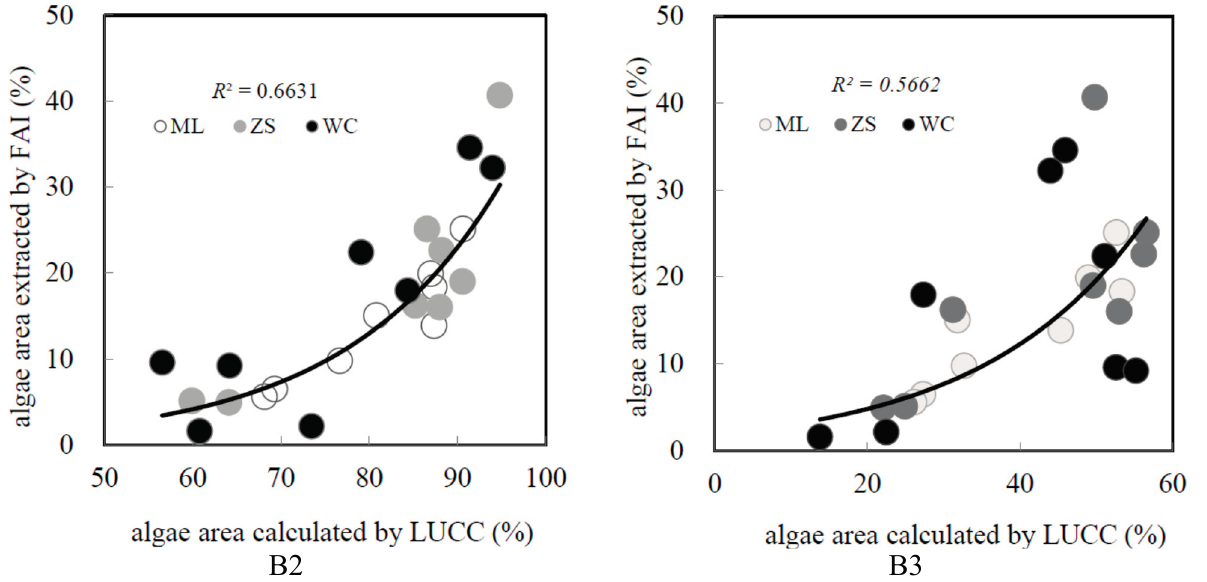
Figure 5. Scatter plots of algal area calculated by LUCC and algal area extracted by FAI for the B2 and B3 buffer